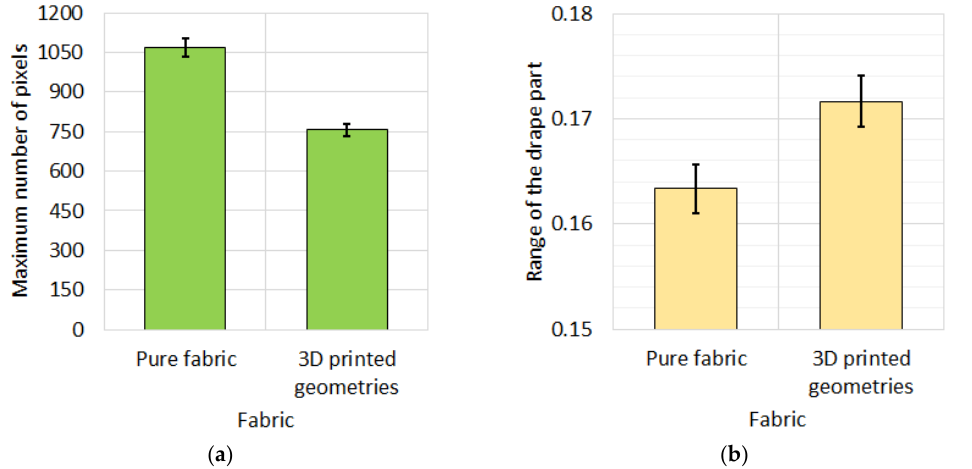
Figure 8 . Amendment of the 3D prints on the image histograms of drapes. ( a ) Maximum number of pixels of the drape region in the histogram; ( b ) dimension of the range of V (HSV) component of drape region in the histogram. The values are significantly different at p < 0.05 .